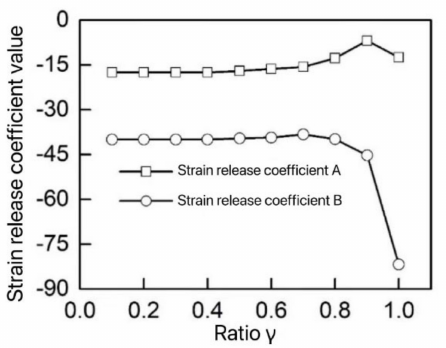
Figure 5. Variation curve of strain release coefficients A and B with ratio γ